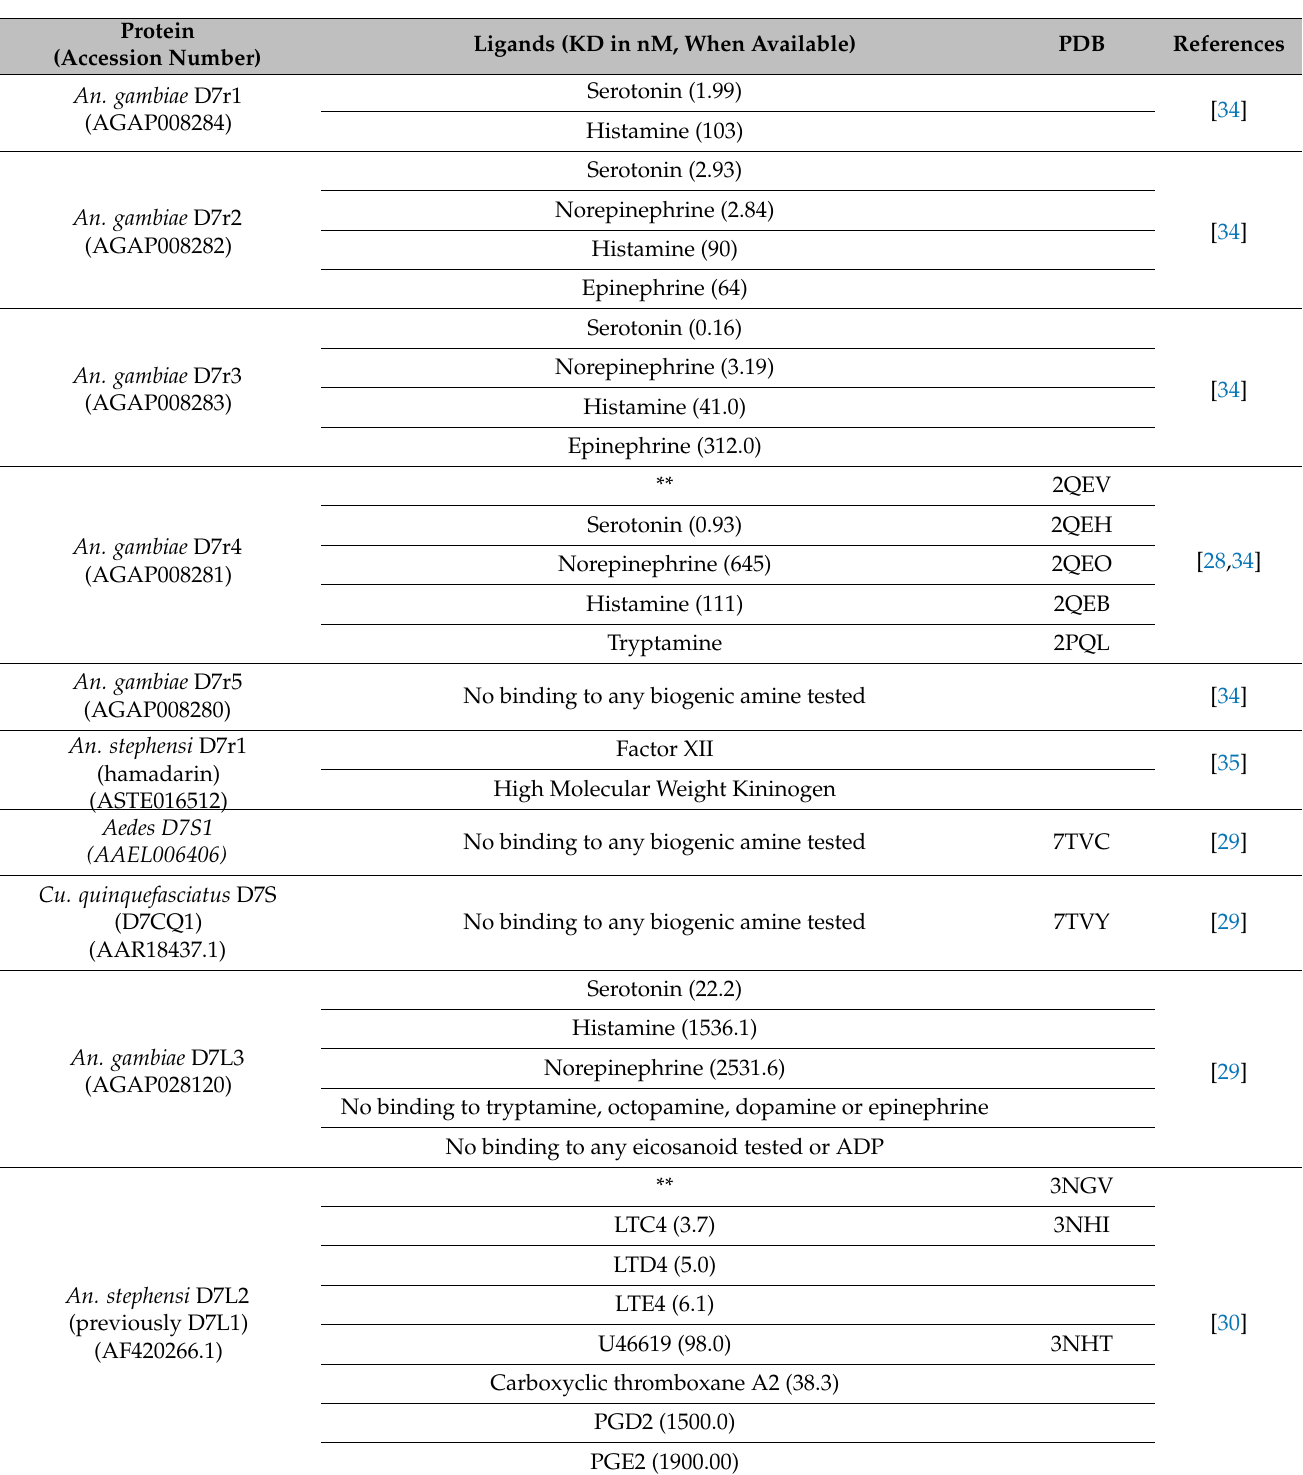
Table 1. D7s and OBP-like proteins characterized in Nematocera, respective ligands and PDB accession number (when